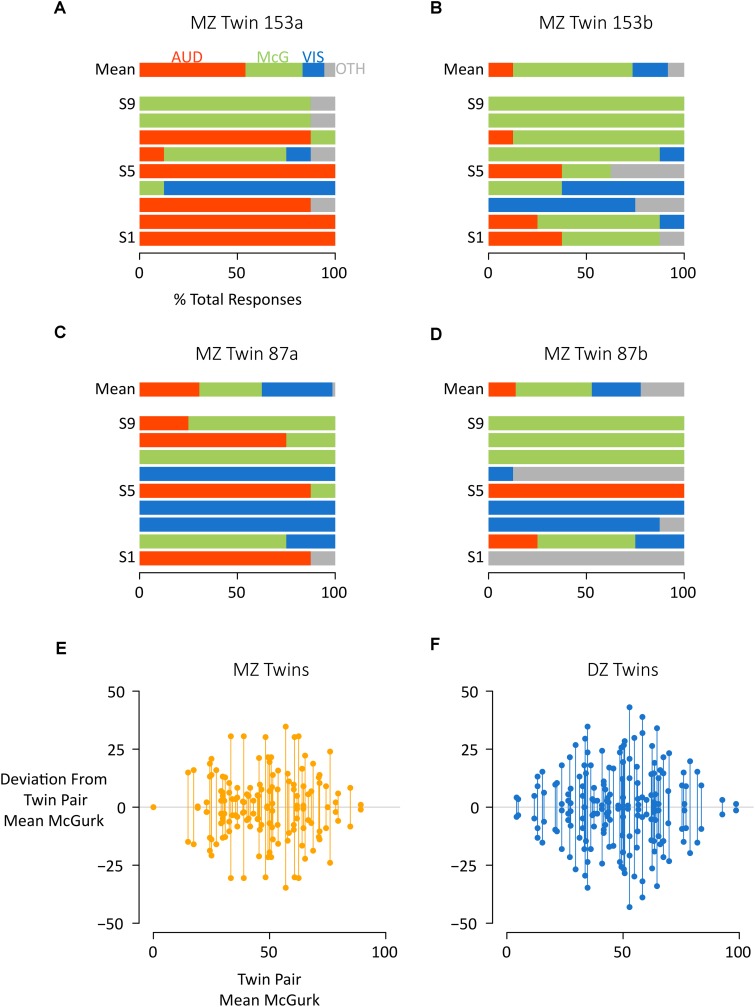
Comparing McGurk susceptibility between and across co-twins. (A) For a single participant (MZ Twin 153a) the mean response across stimuli (row “Mean”) and for each individual stimulus (successive rows) are shown. For each stimulus presentation, the participant reported a percept, which was classified as auditory (AUD, red), McGurk (McG, green), visual (VIS, blue), or other (OTH, gray). The colored portions of each bar illustrate the percentage of each response type across repeated presentations of the same stimulus. For instance, the red color of the bar labeled “S1” indicates that the participant reported an auditory percept for every presentation of stimulus “S1.” (B) For the other co-twin in this pair (MZ Twin 153b) a different pattern of responses was noted. For instance, for stimulus “S1”, a majority of participant reports corresponded to the McGurk percept. (C,D) Co-twins MZ Twin 87A and 87B showed more similar responses across stimuli. (E,F) To examine individual twin pairs, the % McGurk reports within each twin pair was calculated, and the deviation from this mean plotted by showing two circles (one for each co-twin) connected by a vertical line. The average length of the vertical lines indicates the magnitude of the intraclass correlation. The left plot shows all MZ twins (orange circles), the right plot shows all DZ twins (blue circles). Within each plot, twin pairs were ordered by mean% McGurks, from least to most. For instance, the left-most orange symbol pair shows two co-twins both with 0% McGurk, while the right-most blue symbol shows two co-twins with 97 and 100% McGurk.